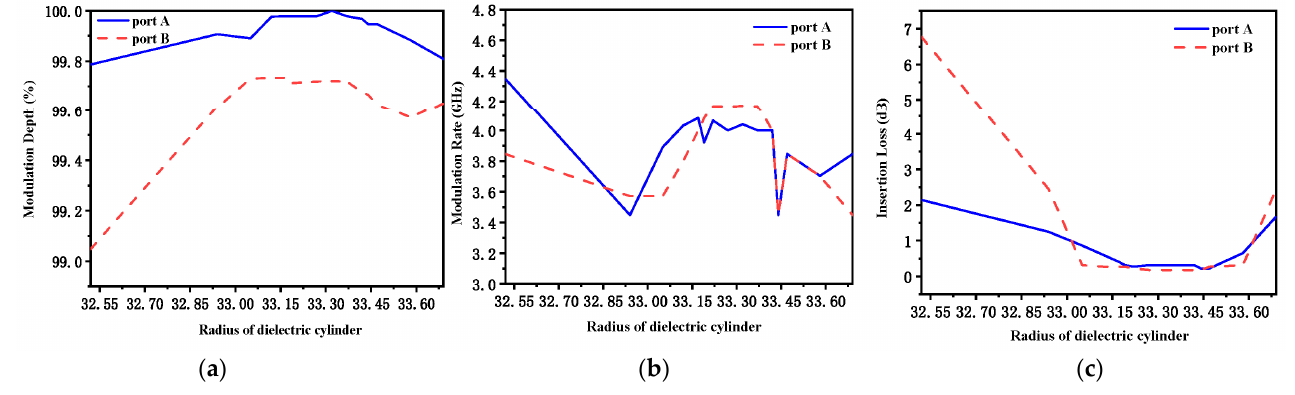
Figure 7. ( a ) The modulation depth of input port A and port B with the radius of the silicon dielectric cylinder in the range of 32.52–33.69 μ m. ( b ) The modulation rate of input port A and port B with the radius of the silicon dielectric cylinder in the range of 32.52–33.69 μ m. ( c ) The insertion loss of input port A and port B with the radius of the silicon dielectric cylinder changes in the range of 32.52–33.69 μ m.